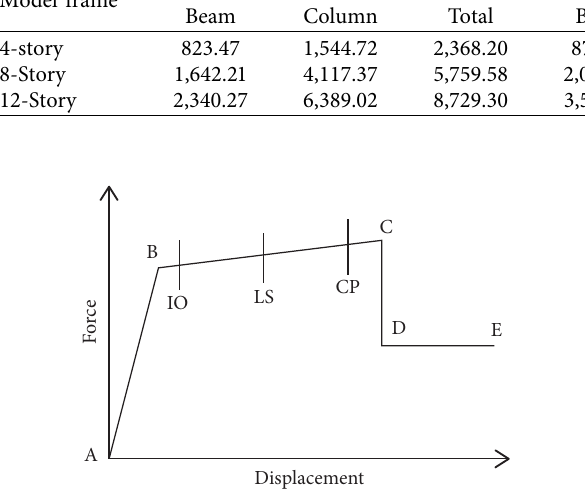
Table 3: Longitudinal rebar (kilogram) quantity in column and beam for model frame designed. Model frame